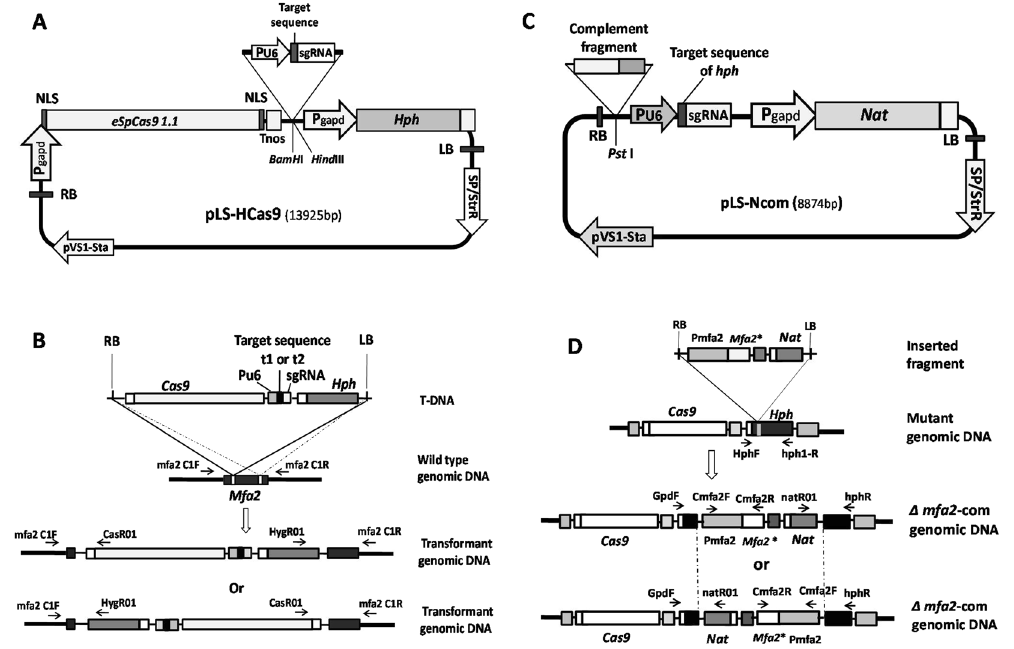
Figure 1. The CRISPR/Cas9 disruption and complementation system. ( A ) Structure of the pLS-HCas9 binary vector for gene disruption. ( B ) Schematic representation of the targeted gene disruption and the primers used for PCR identification. ( C ) Structure of the pLS-Ncom binary vector for gene complementation. ( D ) Schematic representation of the Mfa2 complementation strategy and the primers used for PCR identification. * Mfa2 with target sequences